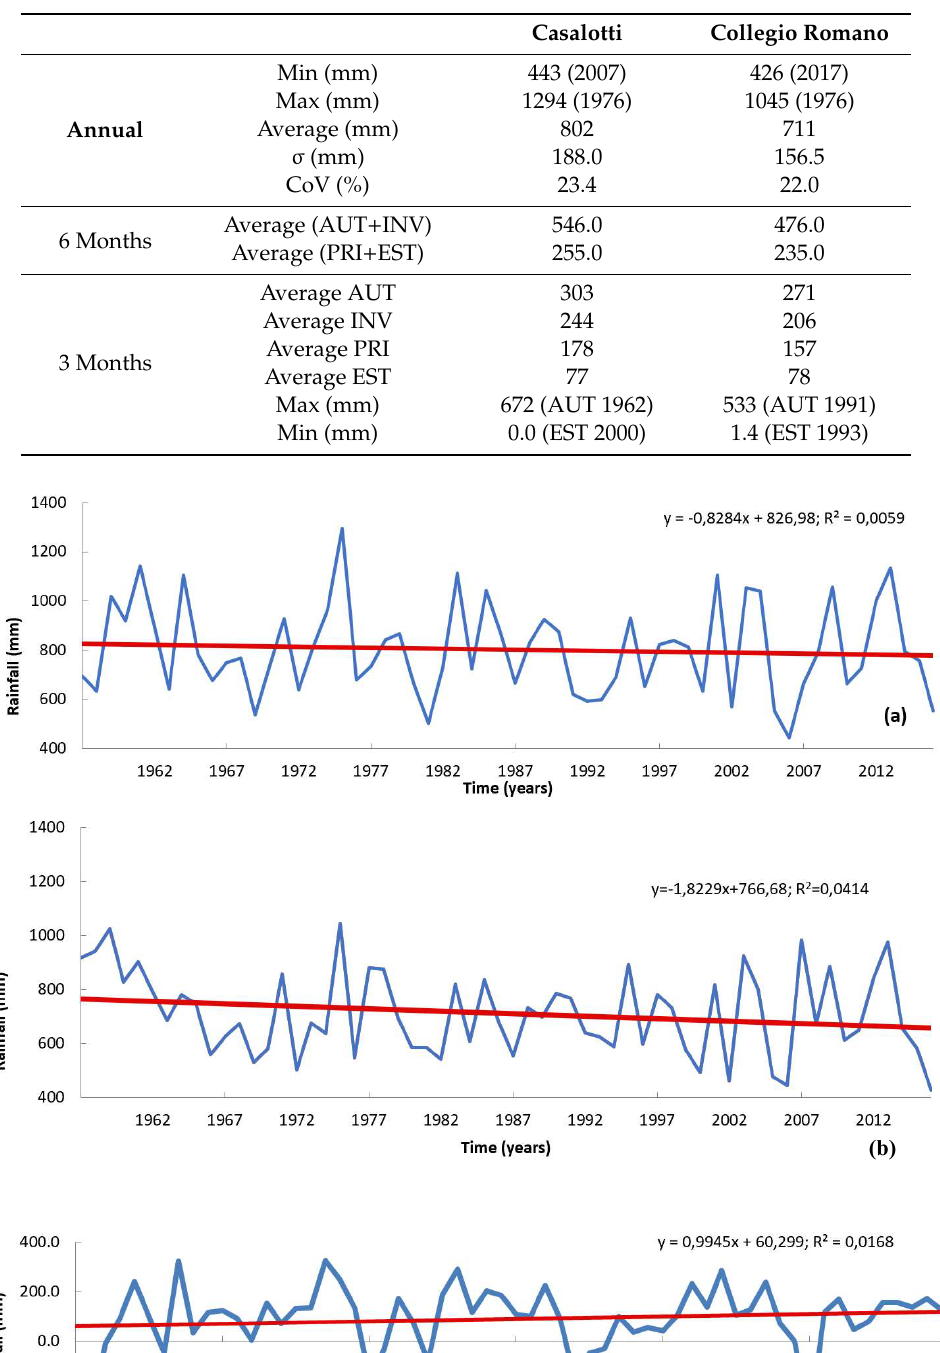
Table 1. Summary statistics of different temporal rainfalls at Casalotti and Collegio Romano sites, 1958–2017; (AUT = autumn, INV = winter, PRI = spring, EST = summer).